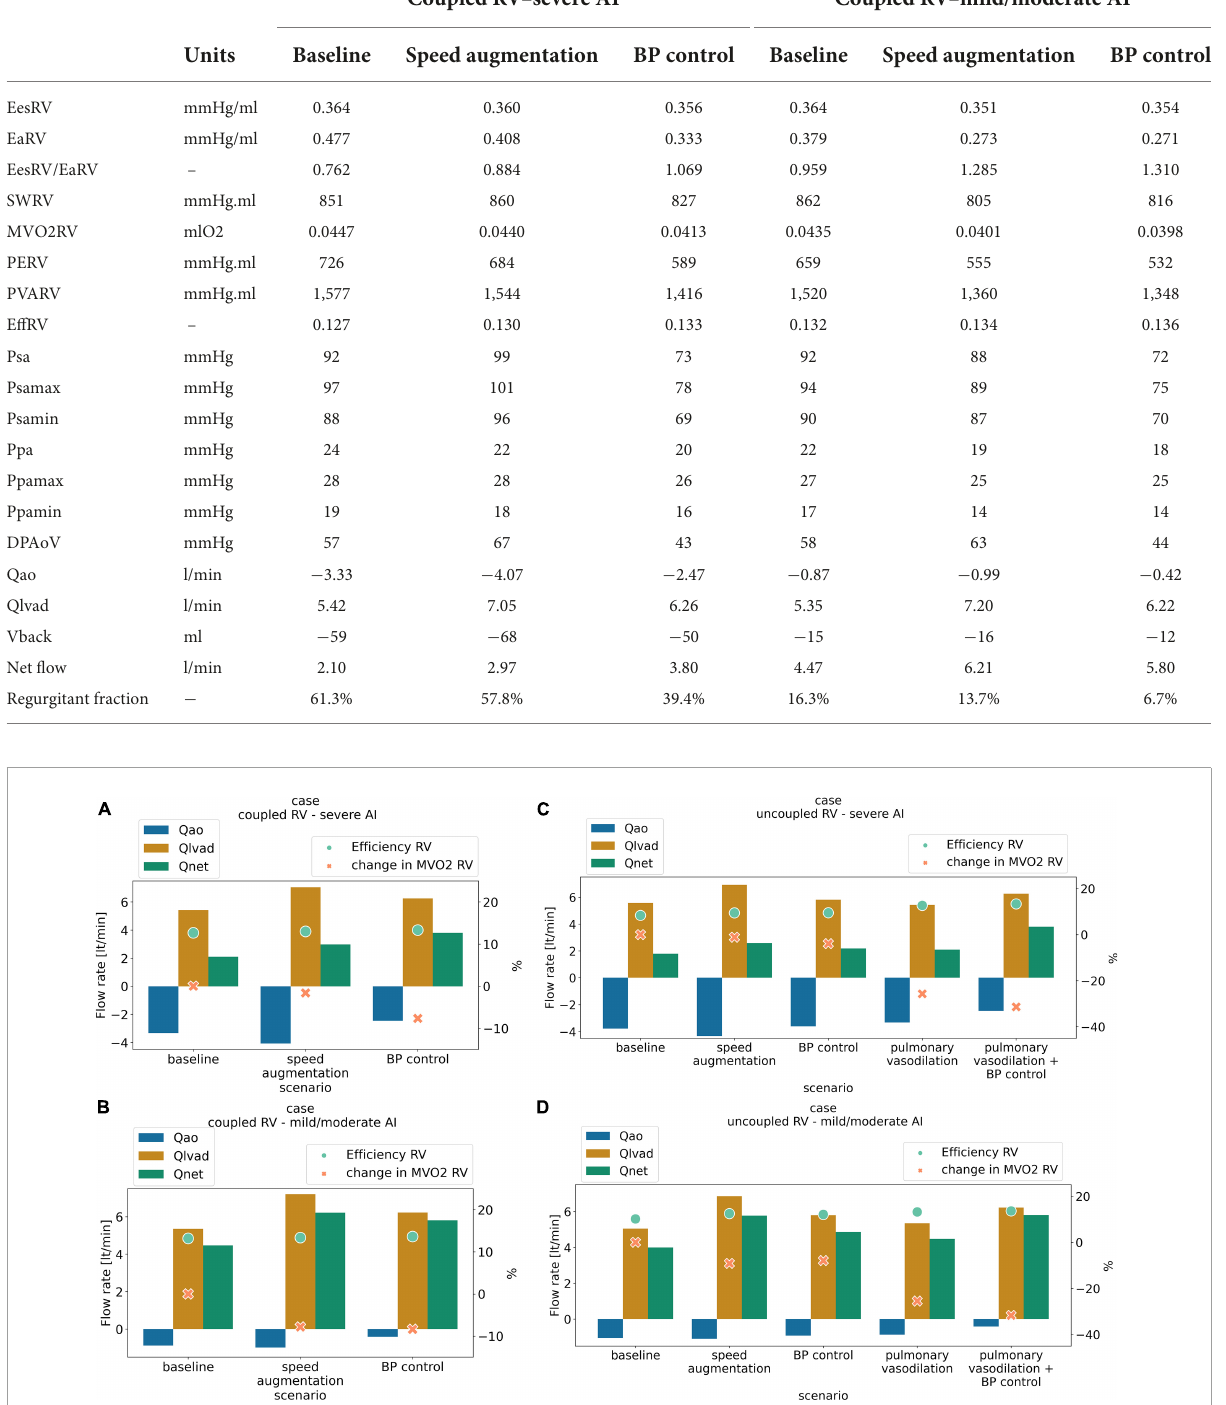
TABLE 1 Intracardiac hemodynamics, energetics, left ventricular assist device (LVAD), and aortic flow with a coupled right ventricle with varying degrees of aortic insufficiency.